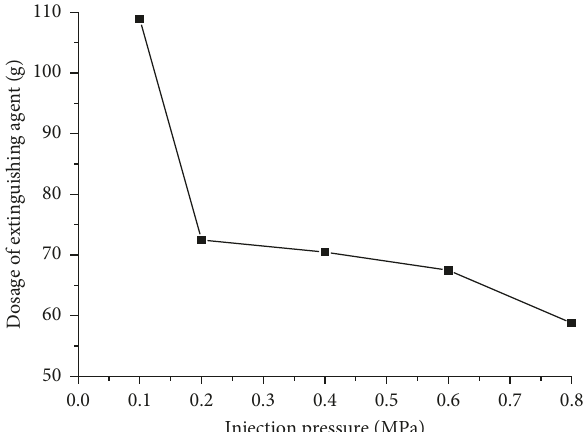
Figure 3: Dose of extinguishing agent under different injection pressures.